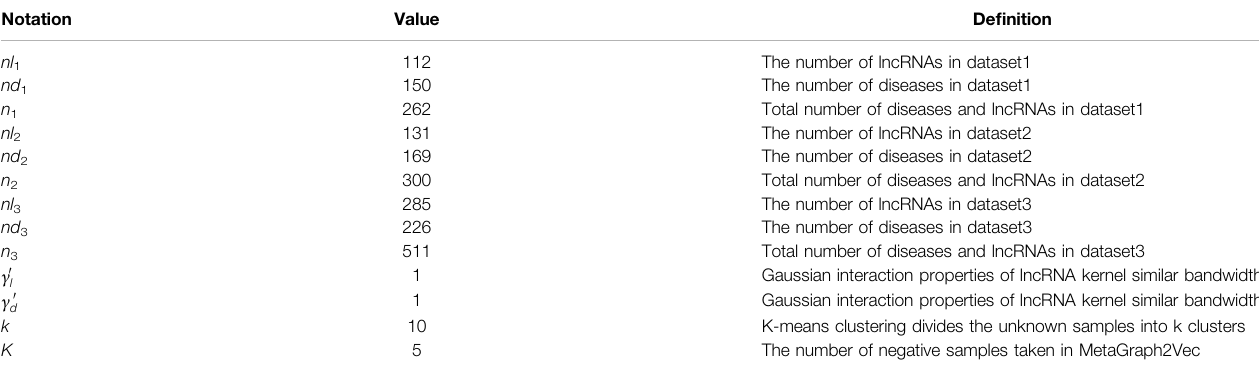
TABLE 2 | The partial experimental parameters of GBDTLRL2D.